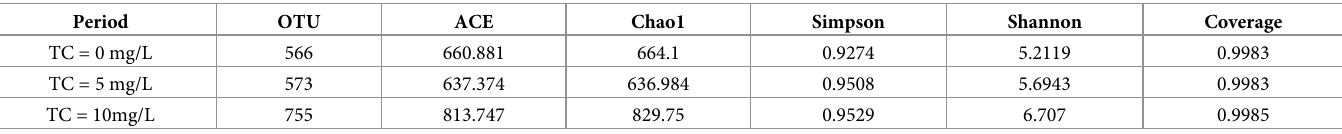
The evolution of microbial community diversity. Generally, ACE and Chao indexes were used to measure the relative abundance of species, and the Shannon and Simpson indexes were used to measure the diversity of species. The Alpha diversity in each period of MBBR sys- tem was shown in Table 2 . The OTU, ACE and Shannon of the microbial community changed from 556, 660.881 and 5.2119 to 573, 637.374 and 5.6943, respectively, when TC concentration Table 2. Alpha diversity index of MBBR